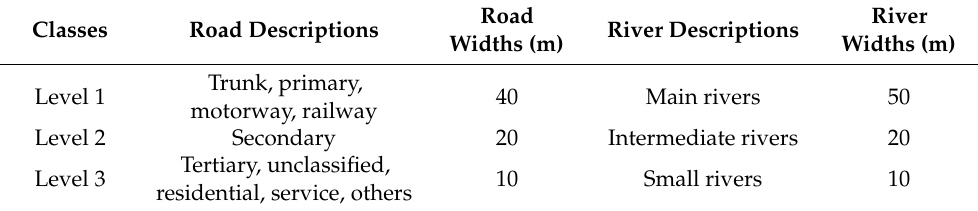
Table 2. The road and river levels and their corresponding buffer sizes used in this